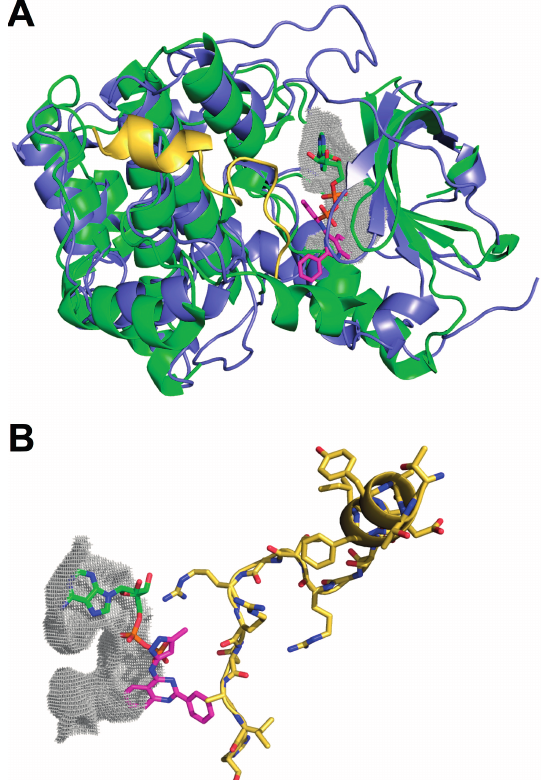
Figure 2. Representation of PKI complexed to PKAC-alpha and the relative position of GSK-3 Inhibitor XIII in the ATP and substrate-binding sites of hNek2. ( A ) Structural alignment between PKAC-alpha (PDB: 1FMO) (blue) and hNek2 (PDB: 2W5A) (green), both displayed in cartoon representation, with a root mean square deviation of 2.010